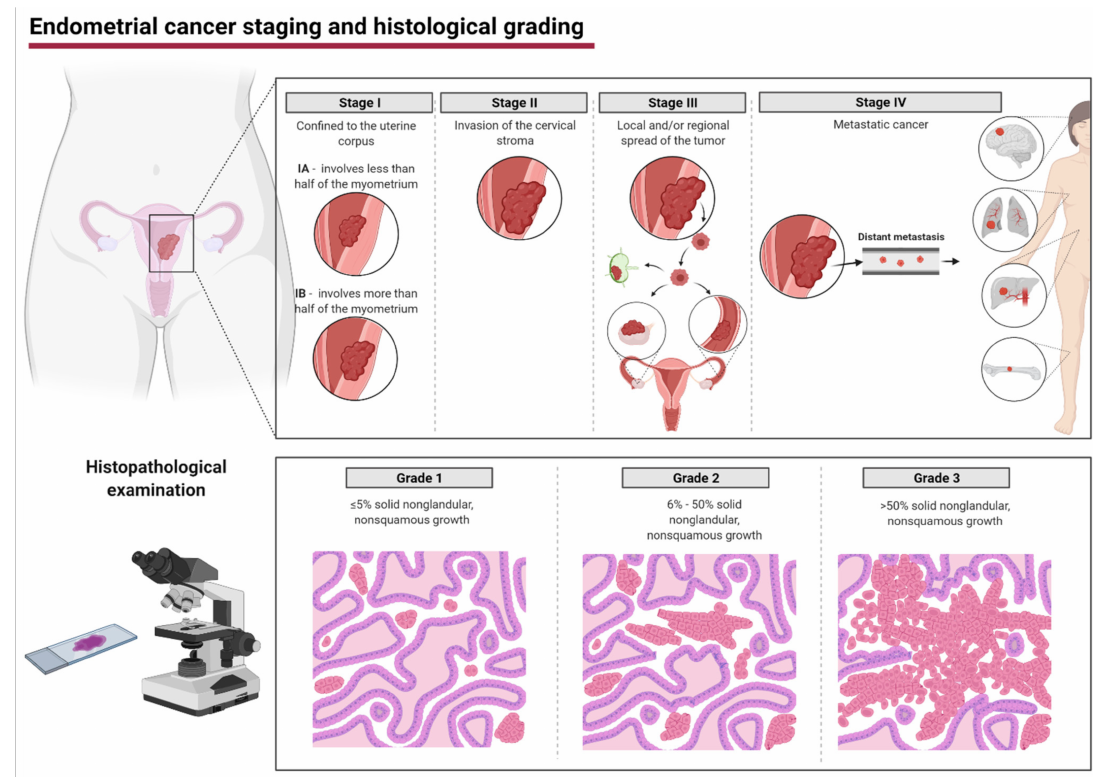
Figure 1. Federation of Gynecology and Obstetrics (FIGO) staging and histological grading of endometrial cancer. Figure was created using